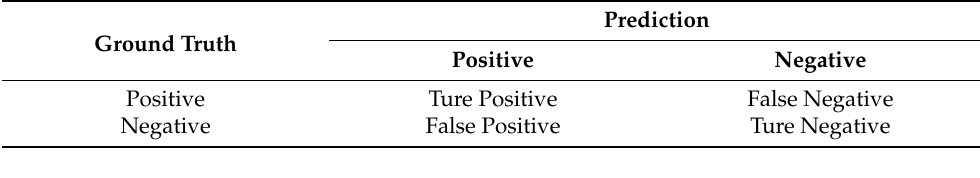
Table 1. The definition of TP , TN , FP , and FN in the confusion matrix.